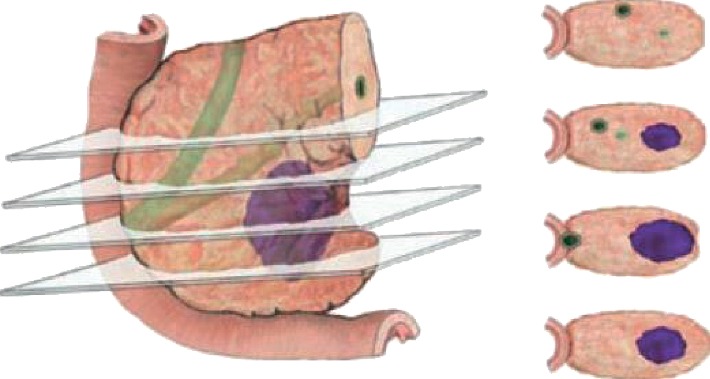
Choose three CT slices [11].